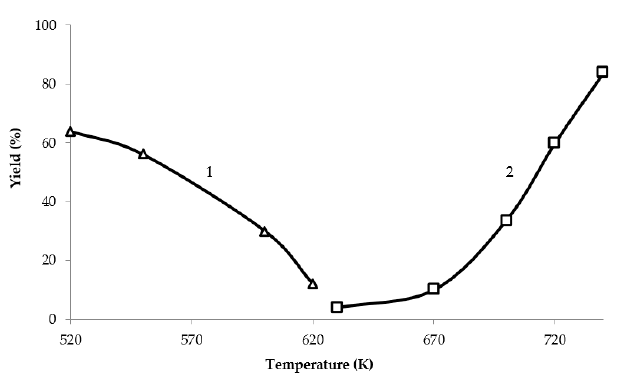
Figure 4. Toluene hydroconversion over Ni-CrA / Al 2 O 3 under hydrogen pressure 0.75 MPa and WHSV = 1.5 h − 1 . (1) - methylcyclopentane and (2) – benzene.